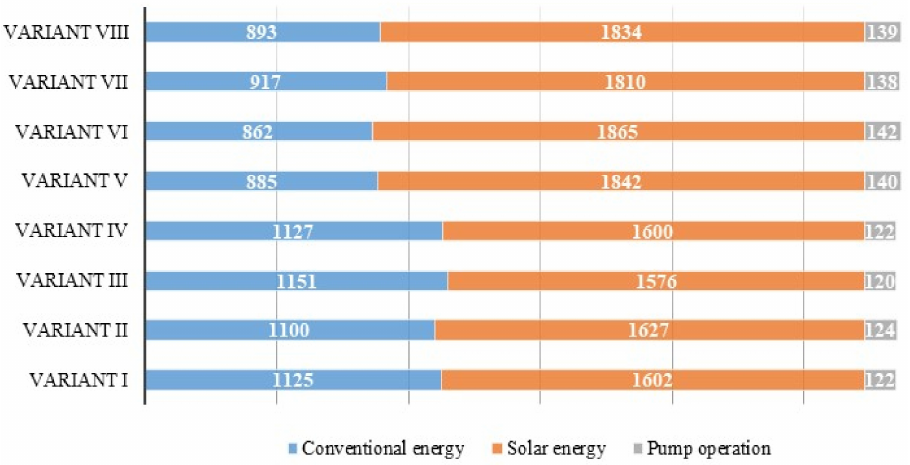
Figure 2. Energy balance of one-year operation of system according to the applied model.